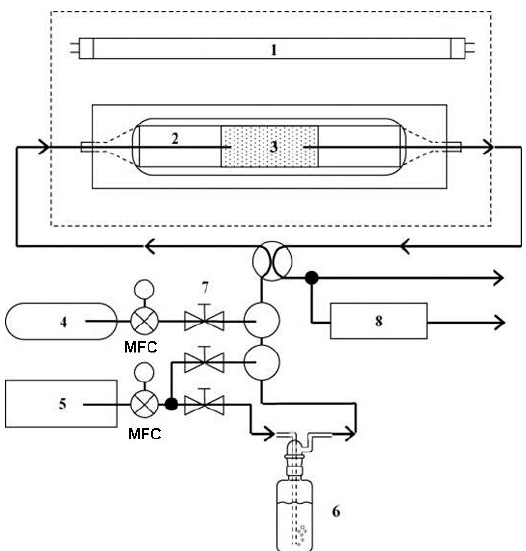
Figure 1. Apparatus for the evaluation of photocatalytic activity in the gas phase. 1: black light tube,